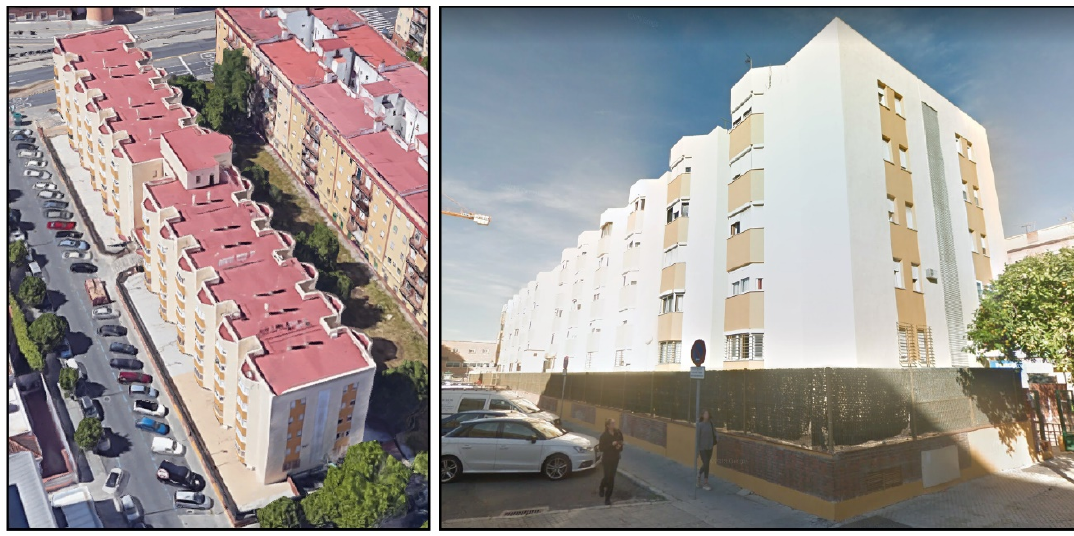
Figure 2. The case study analyzed. Table 1. Thermal properties of the façade layers of the